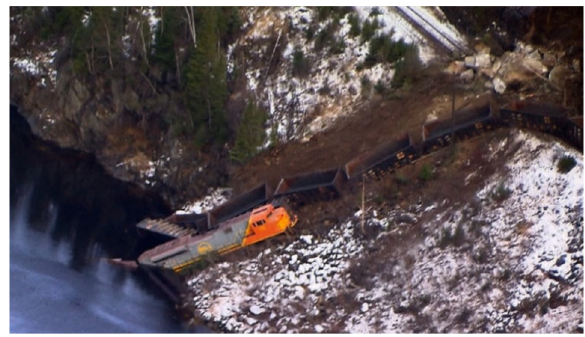
Figure 2 . The derailment of the train in the Moisie river .